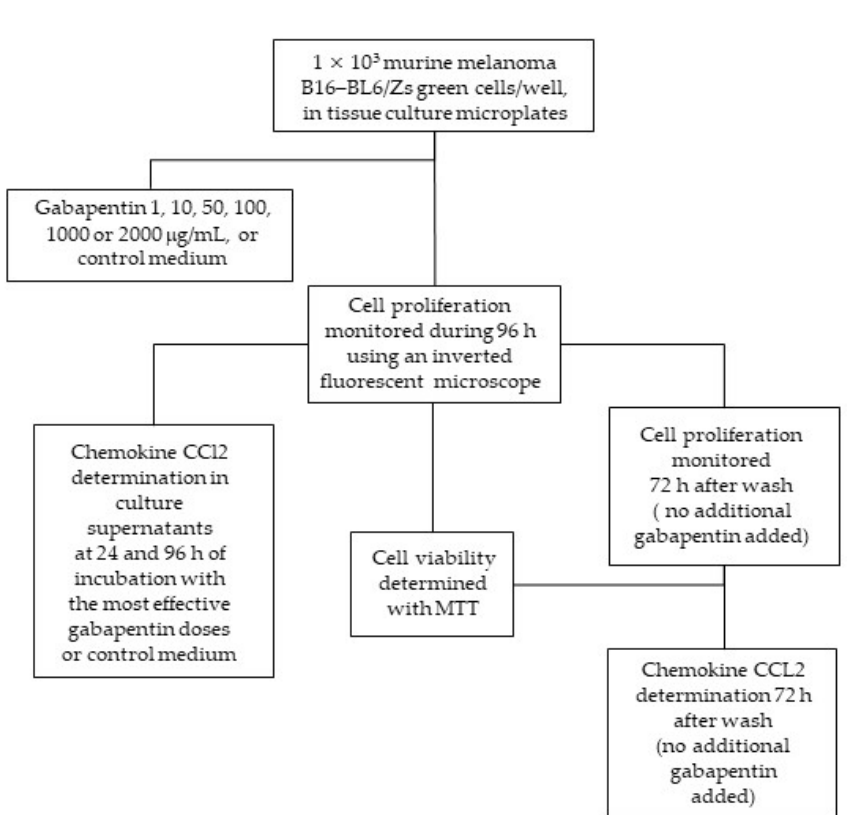
Figure 9. Summary of the in vitro experimental protocol.